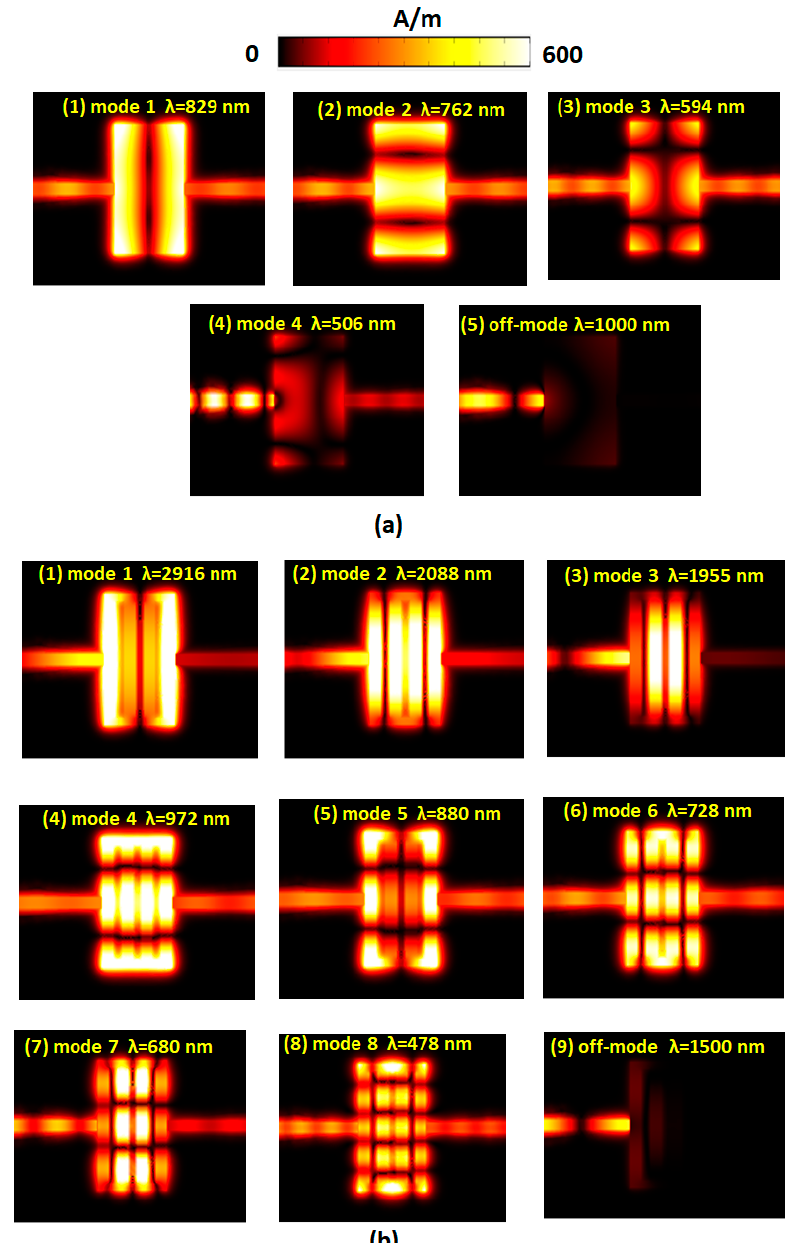
Figure 4. Truncate views of magnetic field intensity (| H |) for the cases ( a ) without Ag baffles at λ res = 829, 762, 594, and 506 nm and ( b ) with Ag baffles at λ res = 2916, 2088, 1955, 972, 880, 728, 680, and 478 nm concerning L = 600 nm, respectively. The off-resonance modes for the case without Ag baffles (at λ = 1000 nm) and the case with Ag baffles (at λ = 1500 nm) are also illustrated for comparison. In the case with Ag baffles, the positive–negative charge pairs (or dipoles) distribute on the edge of the rectangular cavity surface and Ag baffles’ surface, resulting in the remarkable gap and cavity resonance compared to the case without Ag baffles. Besides, the case with Ag baffles contributes more dipoles, which will be beneficial for the coupling effects between nanometals and incident EM waves. Longer L could lead to more charge pairs on Ag baffles’ surface and the cavity edges. This